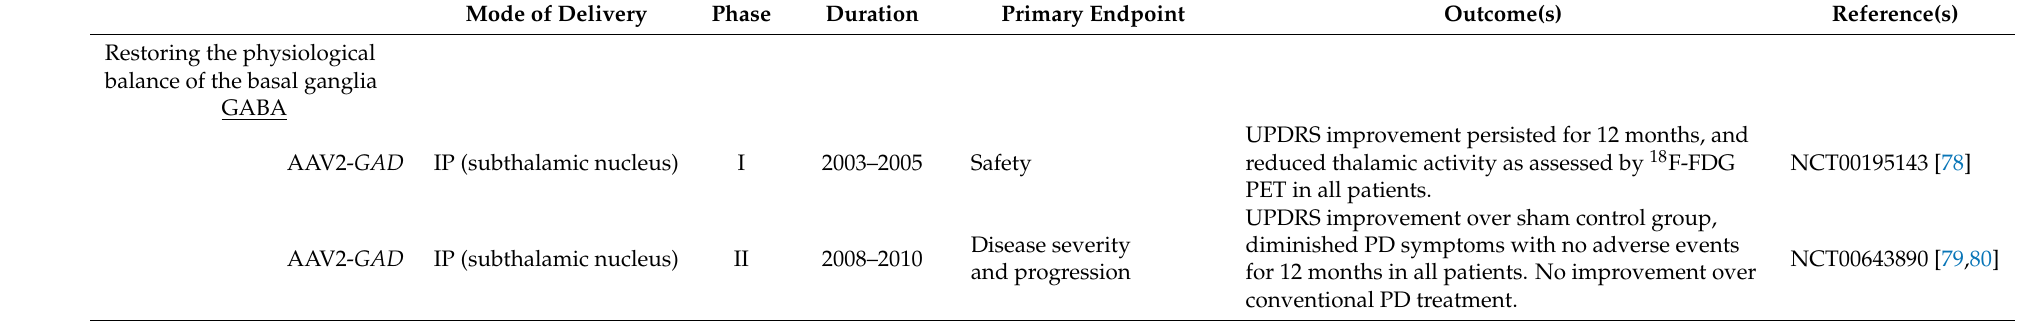
Table 1. Current status of gene therapies for Parkinson’s